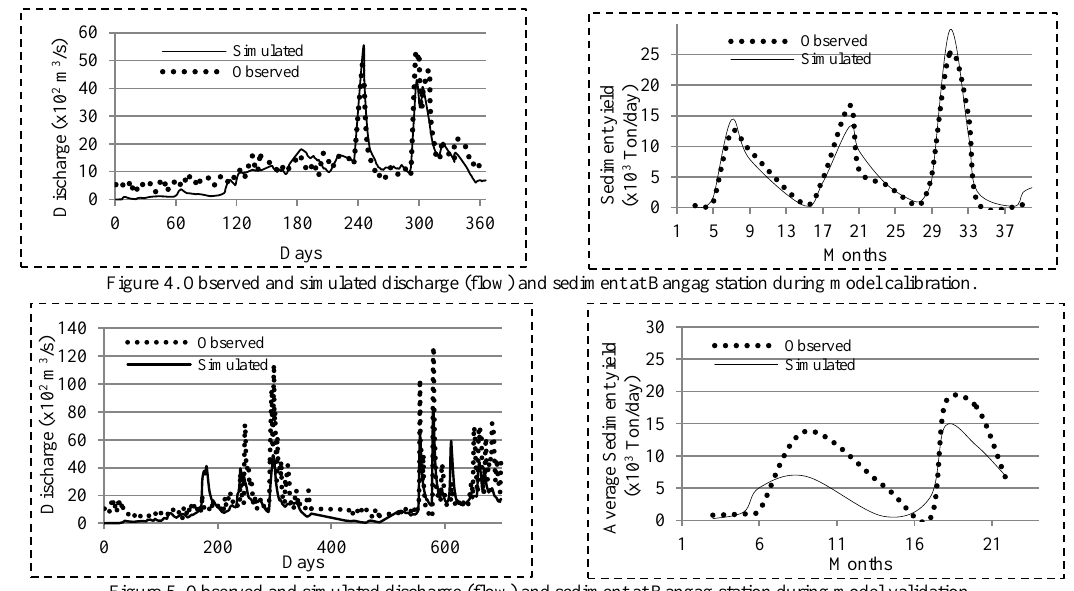
Figure 5. Observed and simulated discharge (flow) and sediment at Bangag station during model